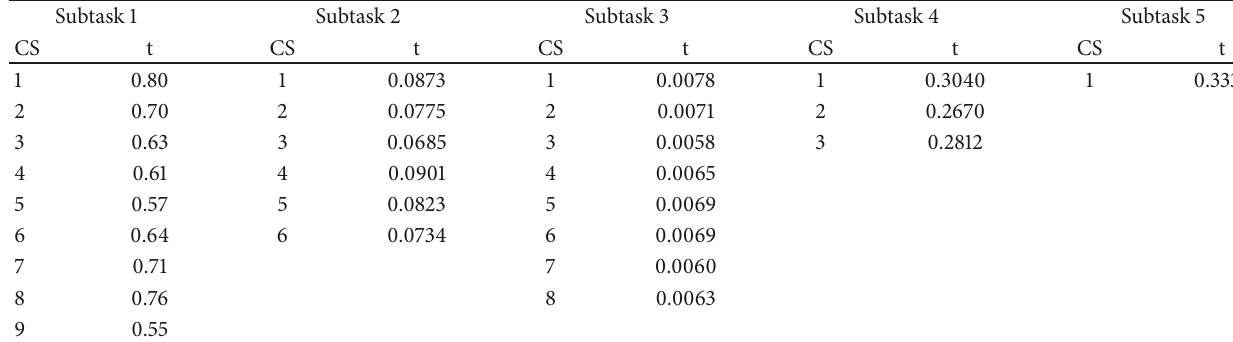
Table 3: : List of candidate